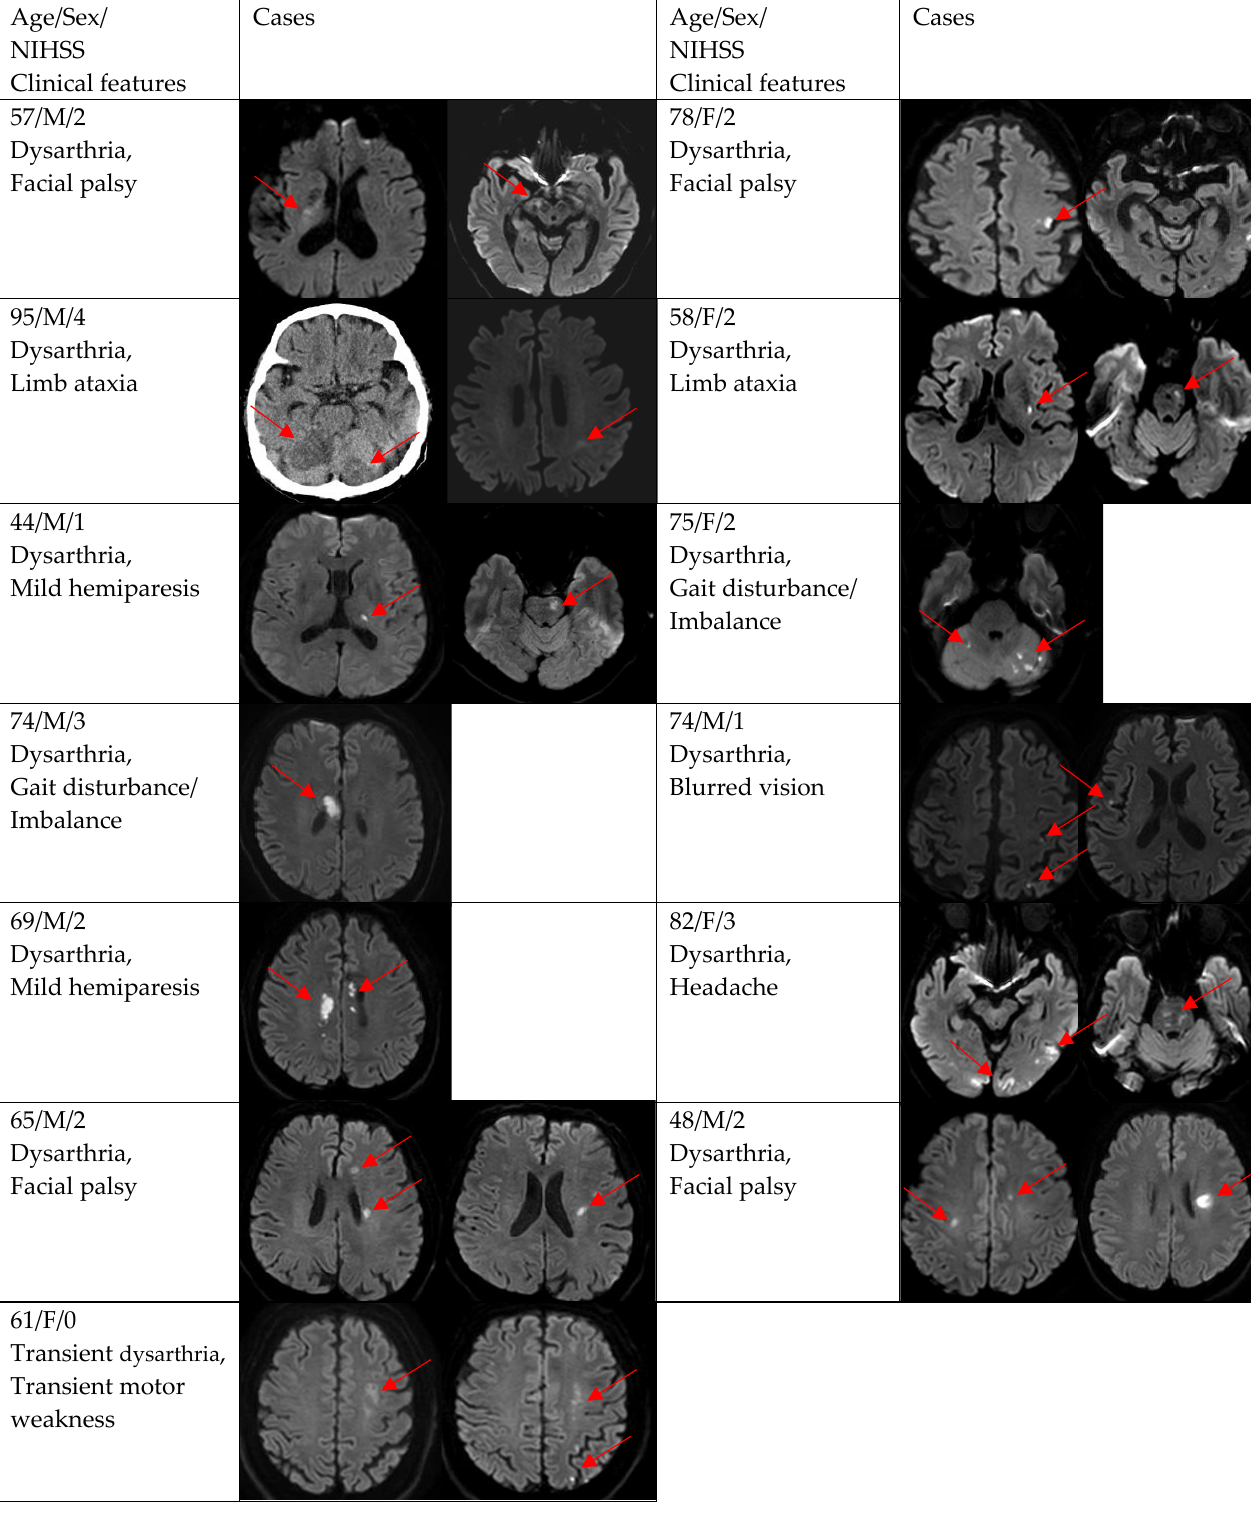
Figure 4. Clinical characteristics and neuroimaging findings of patients with ischemic stroke or TIA presenting with prominent dysarthria and multiple territorial lesions.